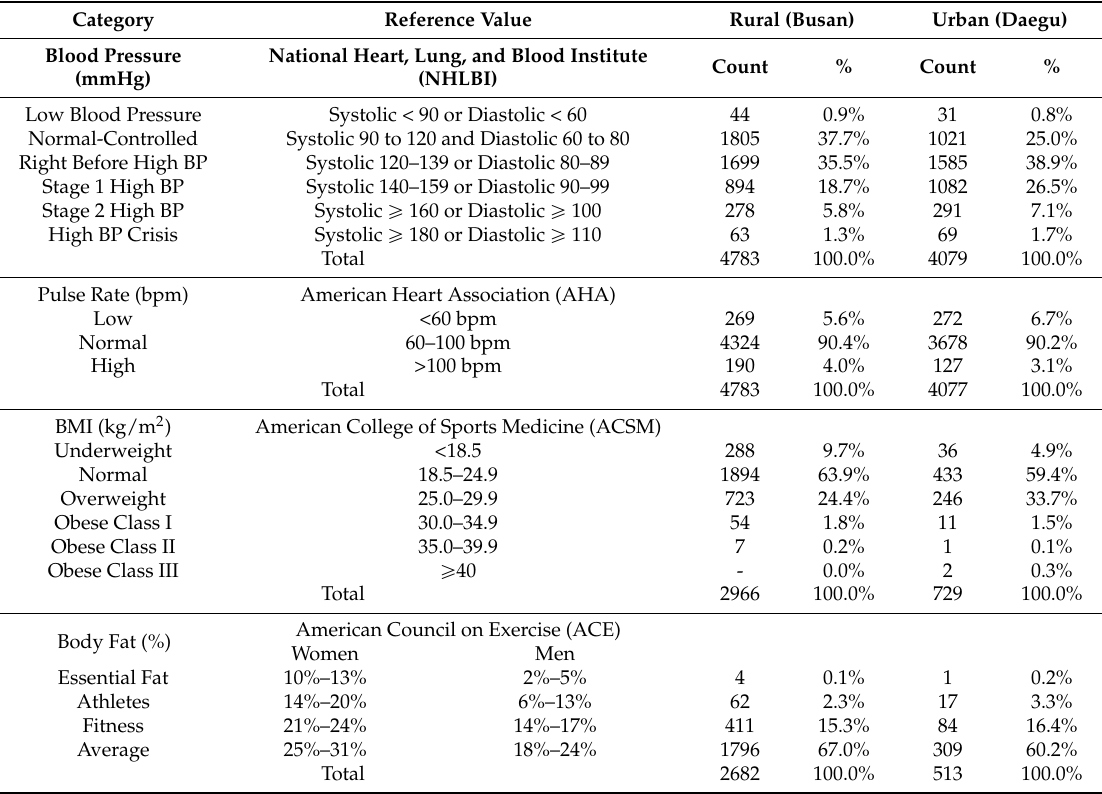
Table 3. Health scores at the U-Healthcare